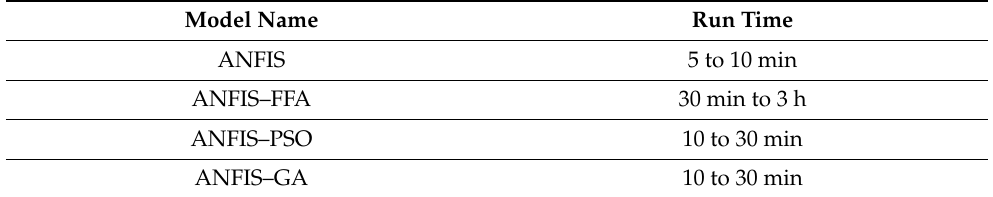
Table 7. Time taken by four models